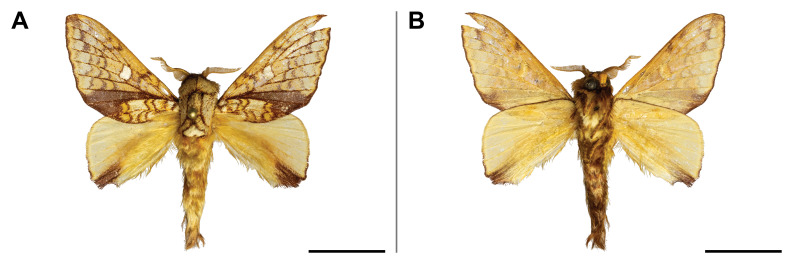
Hypotrabala
castanea Holland, 1893. A. dorsal view; B. ventral view. The scale bar represents 1 cm.